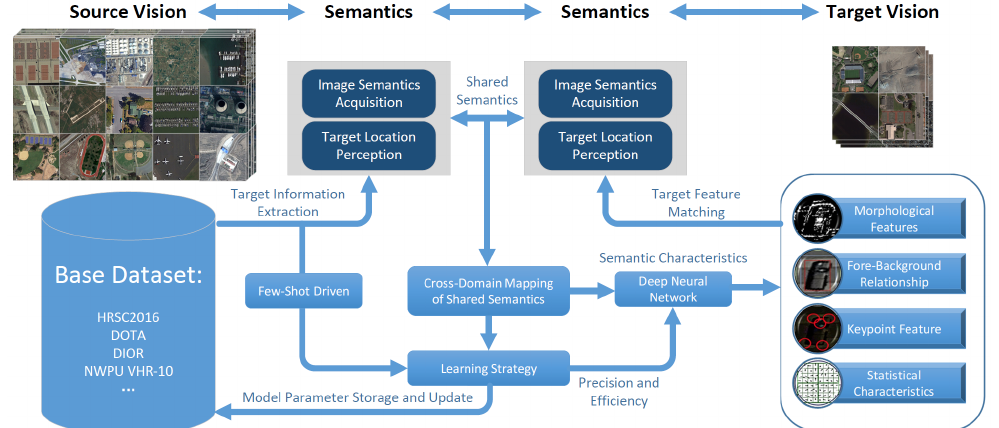
Figure 10. The technical route of few-shot object detection in remote sensing image. FSOD model de- sign follows the cognition process of “source vision–semantics–semantics–target vision”. The shared semantics extracted from samples are transmitted from the source domain to the target domain. The extraction and cross-domain mapping of shared semantics is the key to achieving FSOD. The base dataset in the source domain offers target information for semantics generation. Semantics shared to the target domain achieve feature fusion by target feature matching. Fused features are used for further detection, and the few-shot strategy supports the whole training